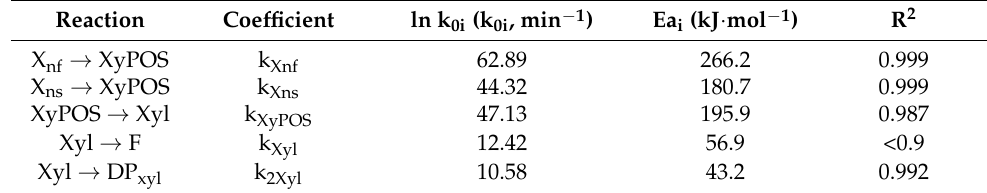
Table 5. Results calculated for parameters (preexponential factors, activation energies, and regression coefficients) governing the reactions of xylan and the derived